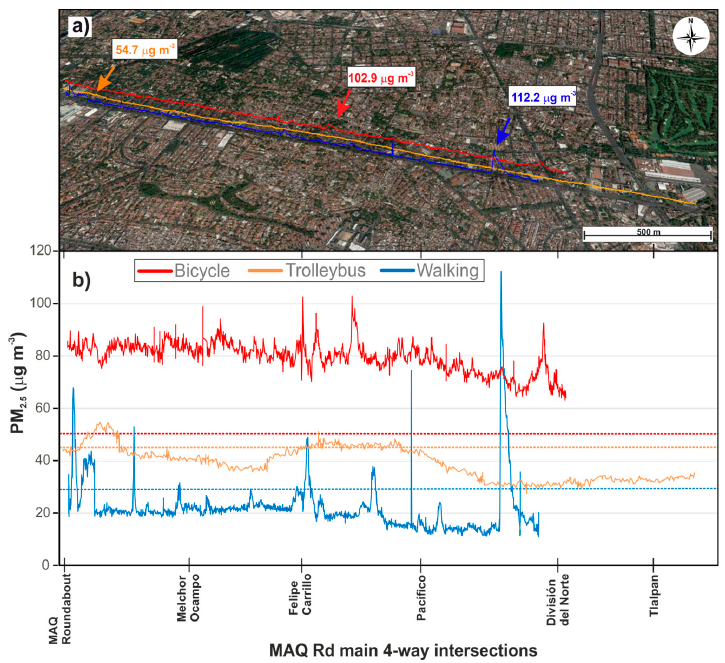
Figure 3. ( a ) Spatial location of PM 2.5 by mode of transport recorded during MAQ to TAX (Taxqueña) journeys; ( b ) PM 2.5 time series per journey. Street names indicated in the X -axis correspond to 4-way intersections. The horizontal dashed lines show corresponding 1-h averages of PM 2.5 recorded at COY used to calculate exposure residuals.